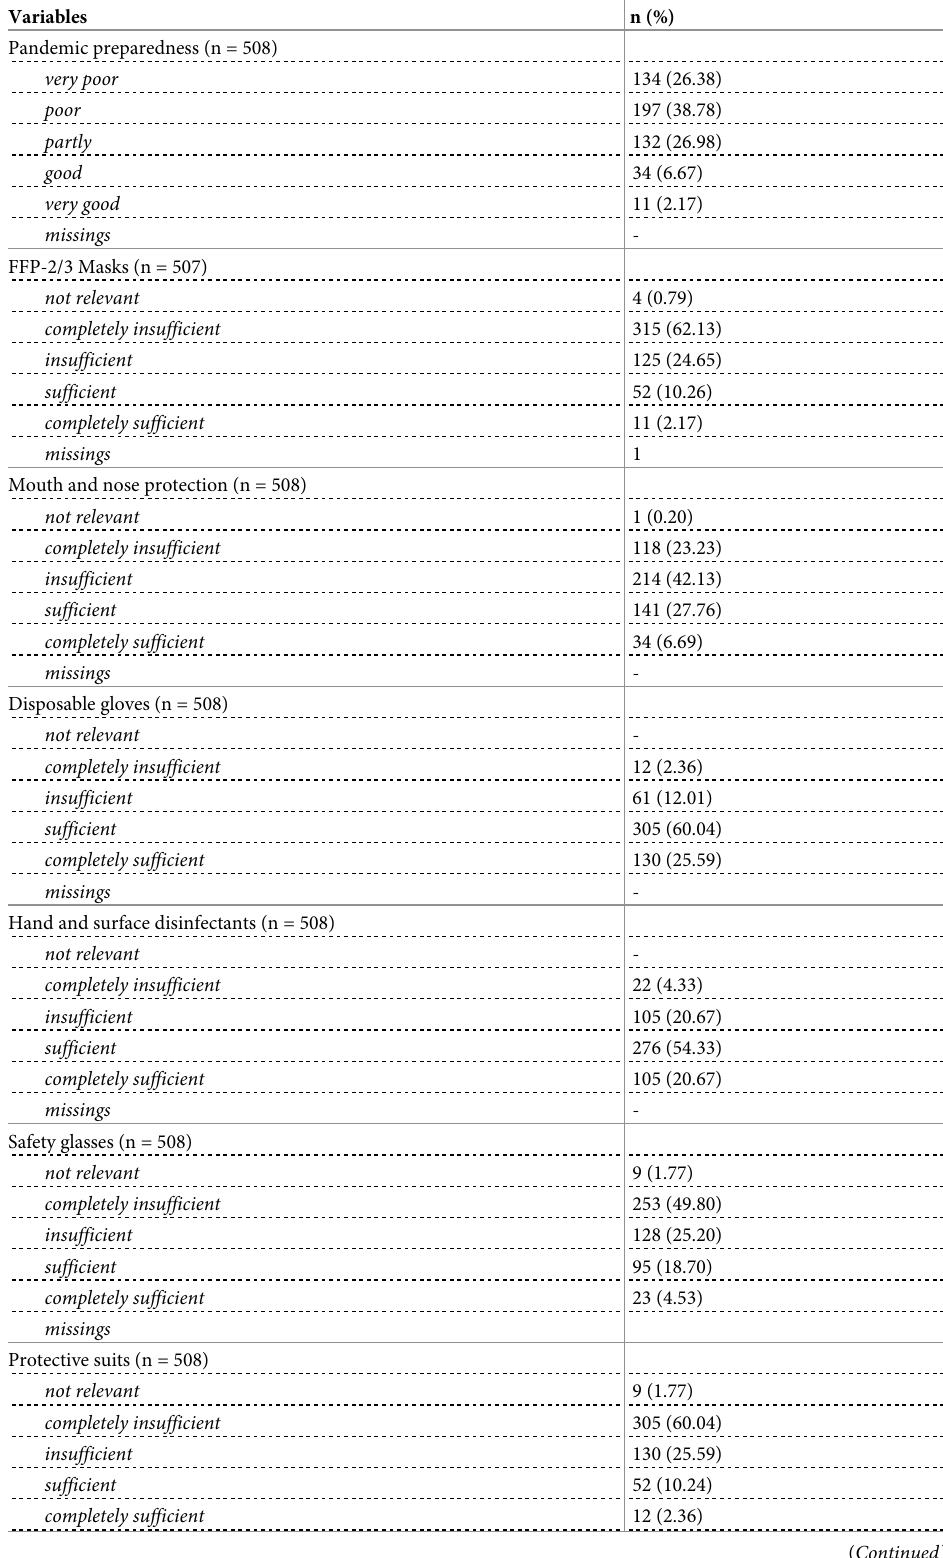
Table 1. General practitioners’ (n = 508) characteristics and pandemic preparedness, personal protective equip- ment, and knowledge on a pandemic plan and its